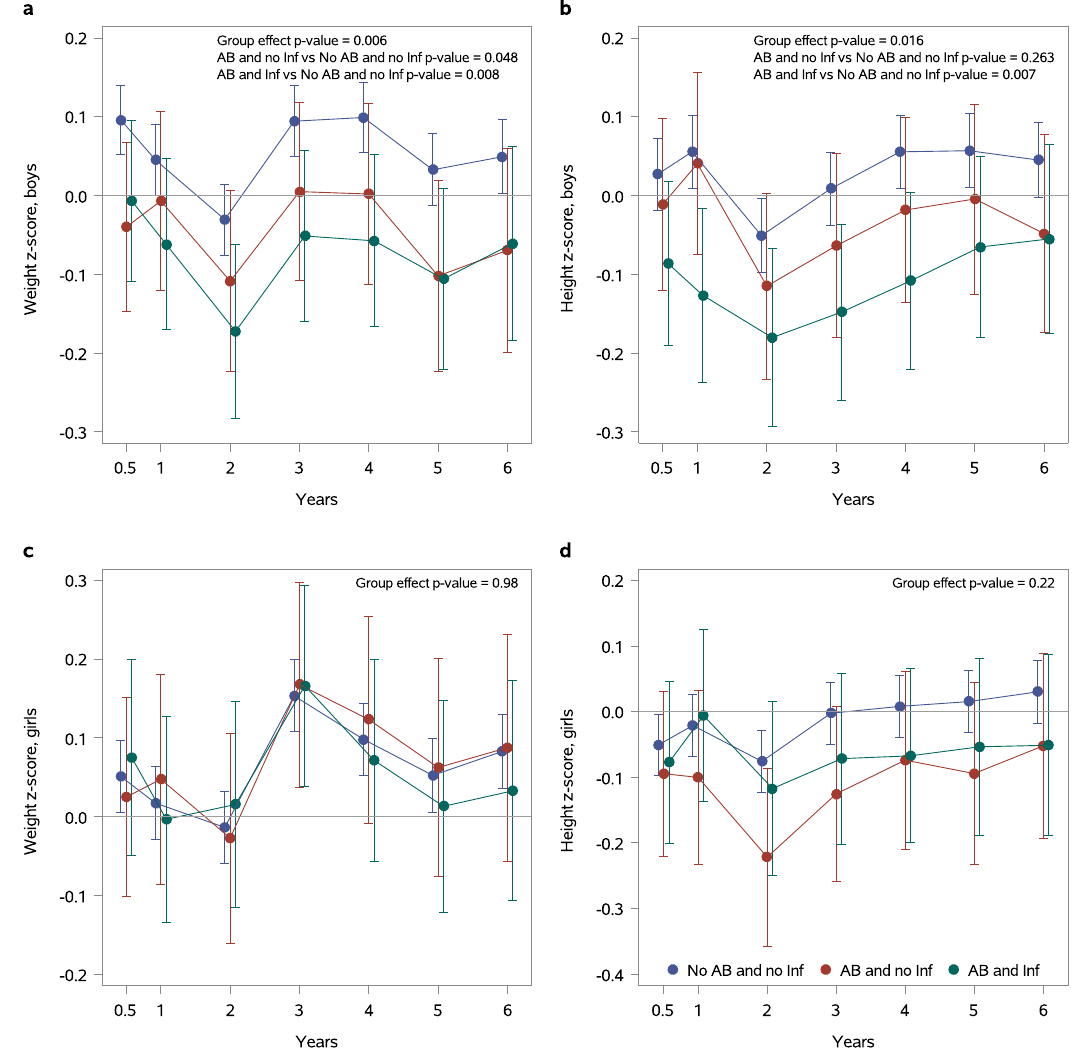
Fig. 1 Neonatal antibiotic exposure is associated with impaired weight and height gain in boys. Growth during the fi rst six years in life in children exposed to brief empirical antibiotic therapy (AB and no Inf, N = 513) and children who had received antibiotics for con fi rmed or clinical bacterial infection (AB and Inf, N = 638) as compared to children not exposed to antibiotics (No AB and no Inf, N = 11,271). Estimates for weight and height Z-scores are presented separately for boys (Fig. 1a Fig. 1b, respectively) and for girls (Fig. 1c Fig. 1d, respectively). The x-axis represents the age in years; the y axis represents the model-based Least Squares Mean (LSM) estimates. The whiskers represent 95% con fi dence intervals. The data were analyzed using a hierarchical linear mixed model for repeated measurements. Neonatal antibiotic exposure, gestational age, birth weight Z-score, mode of delivery, child ’ s age, maternal prepregnancy BMI, and intrapartum antibiotic treatment were included in the model as explanatory variables.